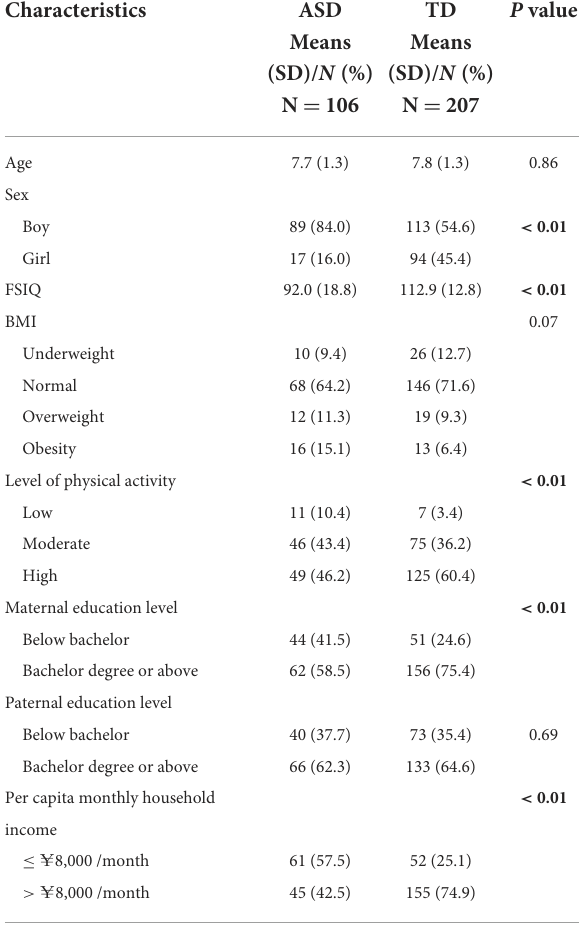
TABLE 1 Demographic characteristics of children with ASD and TD children. Characteristics